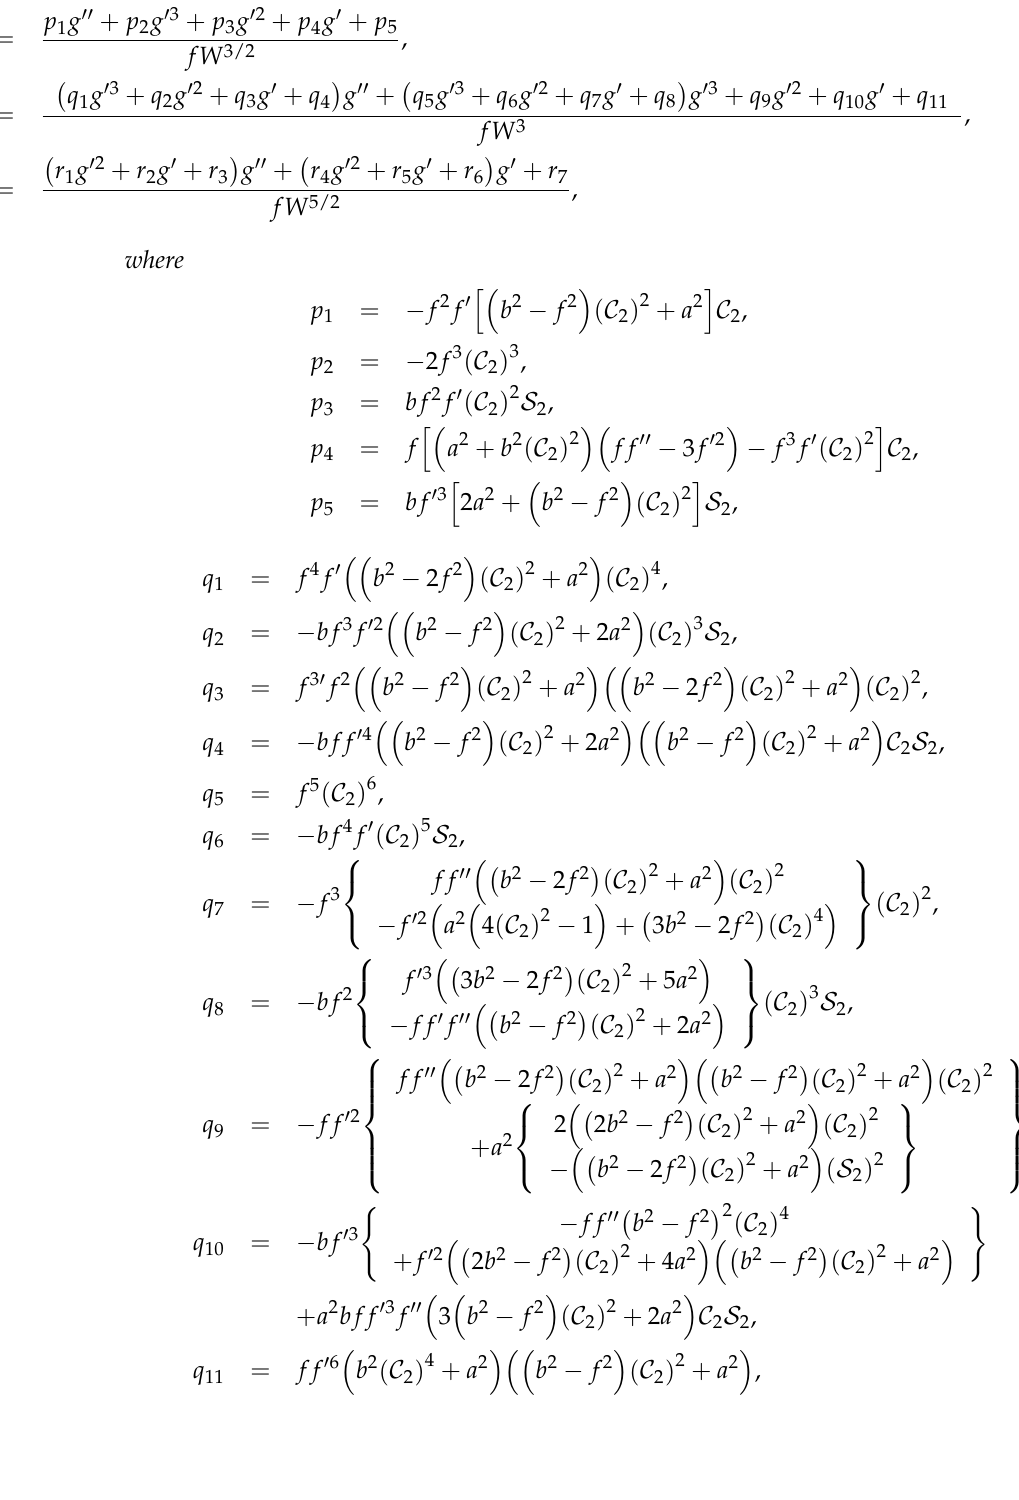
, the generalized helical hypersurface having time-like axis ( 14 ) has the following Theorem 2. In E 4 1 curvatures, respectively, C 0 = 1 by